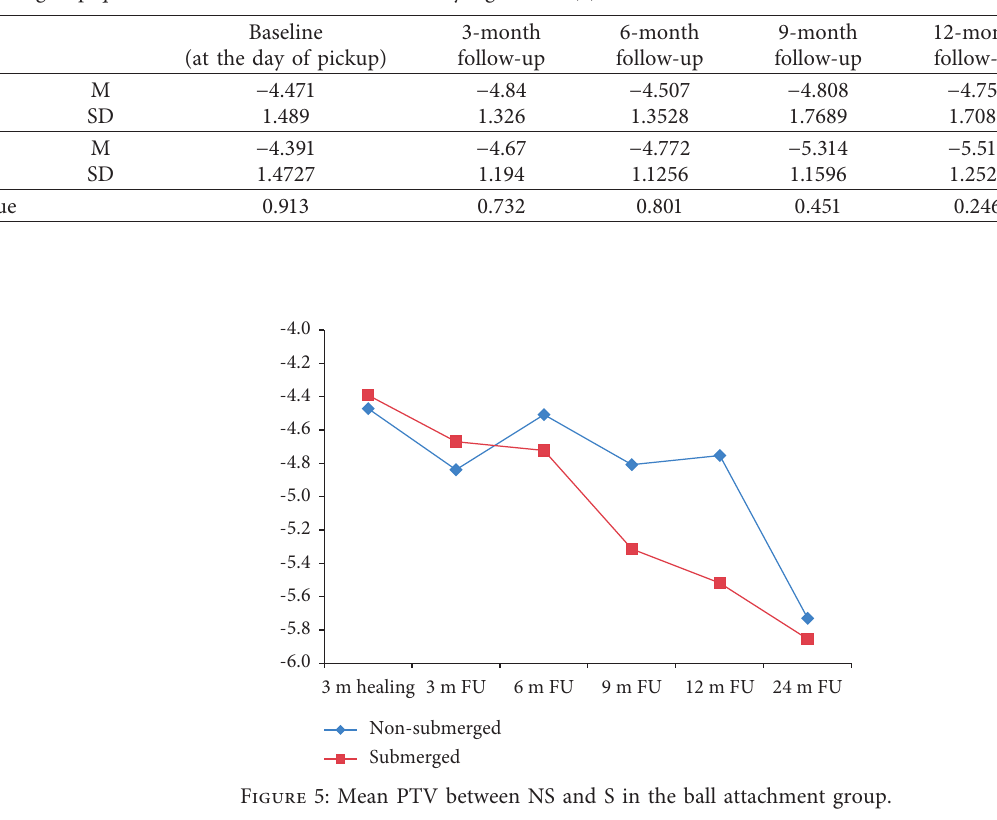
Table 3: The mean � M and standard deviation � SD for the nonsubmerged � NS and submerged � S groups of patients for the ball at- tachment group. p value ≤ 0.05 is considered statistically significant ( ∗ ).